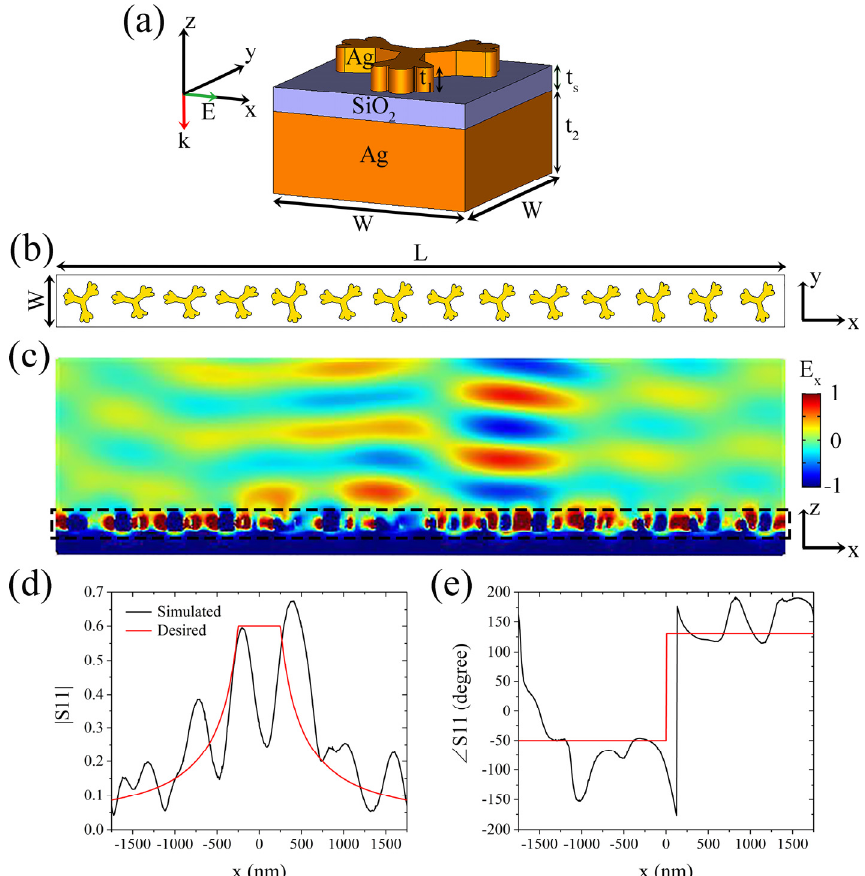
Figure 2. Design and simulation of dendritic metasurface integrator. ( a ) 3D view of the unit in the integral metasurface. t 1 = 30 nm, t s = 30 nm, t 2 = 100 nm, and W = 250 nm, and the incident x-polarized light propagates normally through the metasurface along the –z-axis direction. ( b ) Integral metasurface with 14 different shapes of Ag dendritic units. L = 2 l = 14W = 3500 nm. ( c ) Reflected co-polarized electric field profile obtained when yellow light of wavelength 586 nm is incident on the metasurface. ( d ) and ( e ) show the simulated (black line) and theoretical (red line) position-dependent reflection coefficient amplitude and phase, respectively.